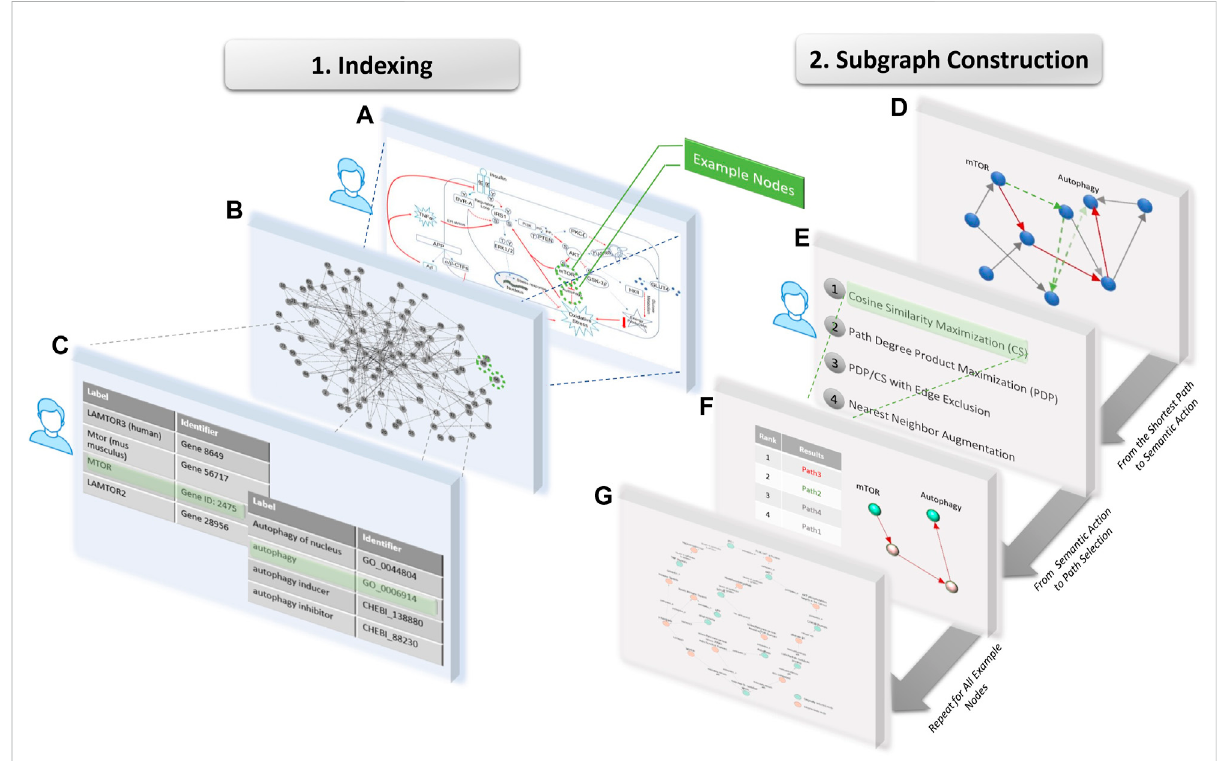
FIGURE 2 Work fl ow used to extract nodes from an original example cartoon, where steps requiring user input are indicated with a person icon. During Indexing, (A) speci fi c concepts, in this case mTOR and autophagy, are selected from the original cartoon as user input, (B) the input concepts are mapped to asets of nodesinthegiven KG using partial string matching (C) then theuser selects 1 nodeto represent each concept. During Subgraph Construction, (D) all shortest paths are identi fi edbetweenthe given pair of nodes, and (E) theuser selects asemantic action which (F) ranks the paths and selects thehighestranked path. (G) This pipeline isrepeatedfor all example node pairs to produce theresulting subgraphfor